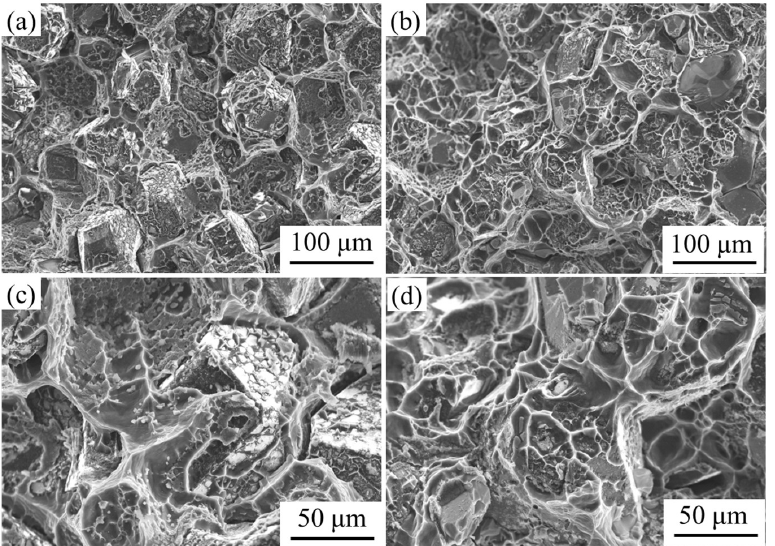
Figure 3. Fracture morphology of diamond/aluminum composites: ( a , c ) uncoated diamond/aluminum composites; ( b , d ) W coated diamond/aluminum composite.